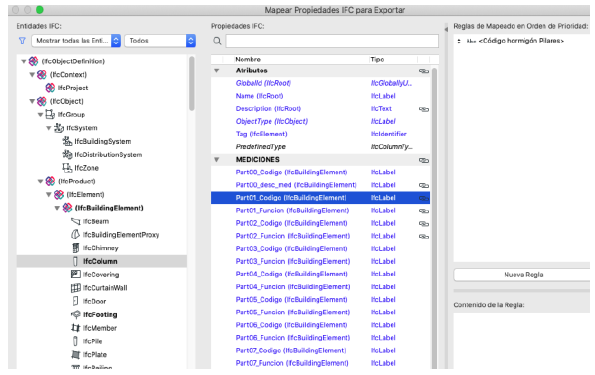
Figure 6. IFC Project Manager: Properties mapped for export of columns in IFC file